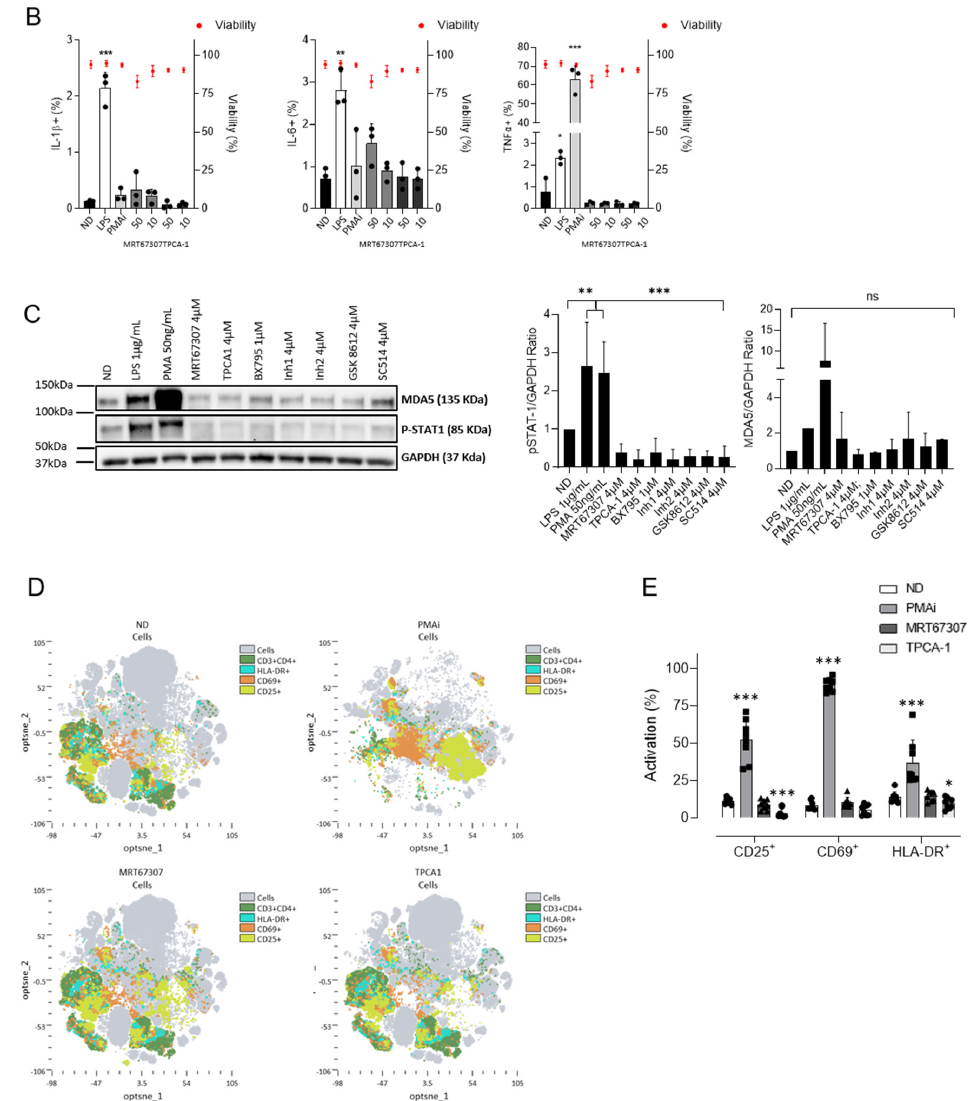
Figure 2. Treatment with IKKi blocks production of inflammatory signals and T-cell activation. ( A ) Gene expression of proinflammatory cytokines IL-1 β , IL-8, CXCL10, and TNF α in HL-60 cells after 16 h of treatment, as measured by RT-qPCR. PMA (0.1 µg/mL) was used as positive control. ( B ) Expression of proinflammatory cytokines IL-1 β , IL-6, and TNF α as measured by intracellular staining by flow cytometry after 24 h of treatment in CD4+ T cells from HIV-negative donors. Viability of CD4+ T cells treated with IKKis as measured by flow cytometry. Black dots represent individual data from independent experiments. Mean ± SD of three independent experiments is shown. ( C ) Evaluation of innate immune activation at protein level. Representative western blot (out of three) showing the inhibition of distinct ISG upon treatment with IKKi (left panel). Semiquantitative analysis of ISG expression upon treatment with IKKi (right panel). ( D ) Distribution of cell surface markers in CD4+ T cells from uninfected donors treated with subtoxic concentrations of MRT67307 (4 µ M) and TPCA-1 (4 µ M) measured by flow cytometry. Distribution was determined by Opt-tSNE-guided manual gating analysis of the signal strength of key phenotypic defining cell activation markers CD25, CD69, and HLA-DR from eight HIV-negative donor samples. Opt-tSNE analysis was performed using 1000 iterations, a perplexity of 30, a trade-off θ of 0.5 as implemented by OMIQ data analysis software (www.omiq.ai). ( E ) Quantification of the cell activation markers compared to resting and PMAi activated CD4+ T cells. Each symbol refers to a distinct patient. Mean ± SD of n = 8 individuals is shown. * p < 0.05; ** p < 0.01; *** p <